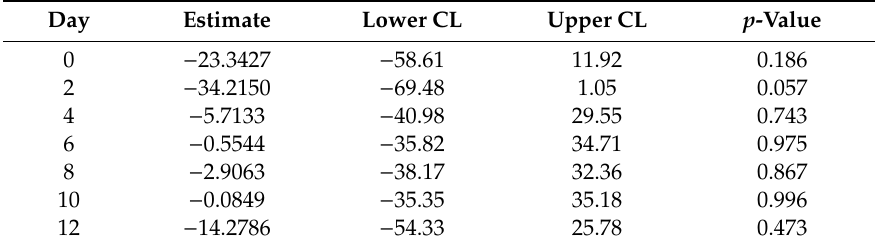
Table 6. Di ff erence between 0-dose and high-dose groups in least square means of OCT4 RNA expression according to day.